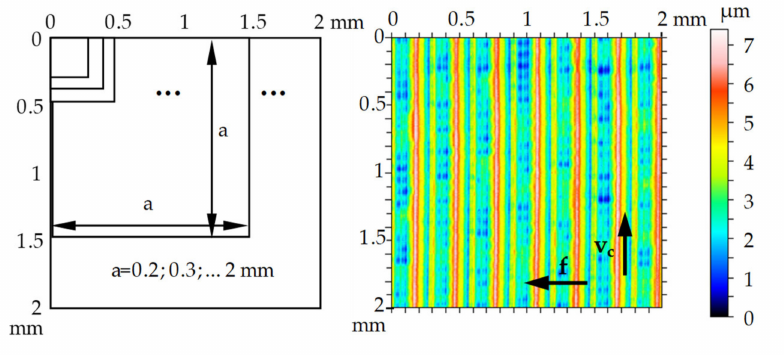
Figure 2. Area sizes applied in the regression